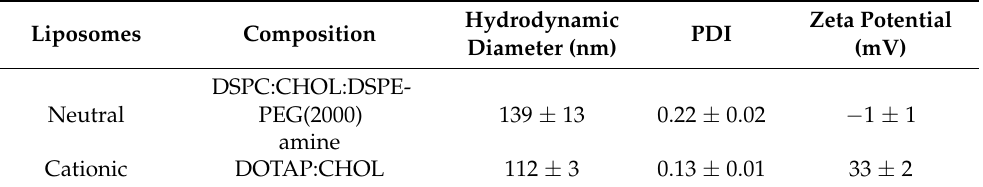
Table 1. Physicochemical properties of neutral and cationic liposomes in terms of hydrodynamic diameter, polydispersity index (PDI), and zeta potential. Hydrodynamic Liposomes Composition Diameter (nm) (mV) DSPC:CHOL:DSPE- Neutral PEG(2000) Cationic